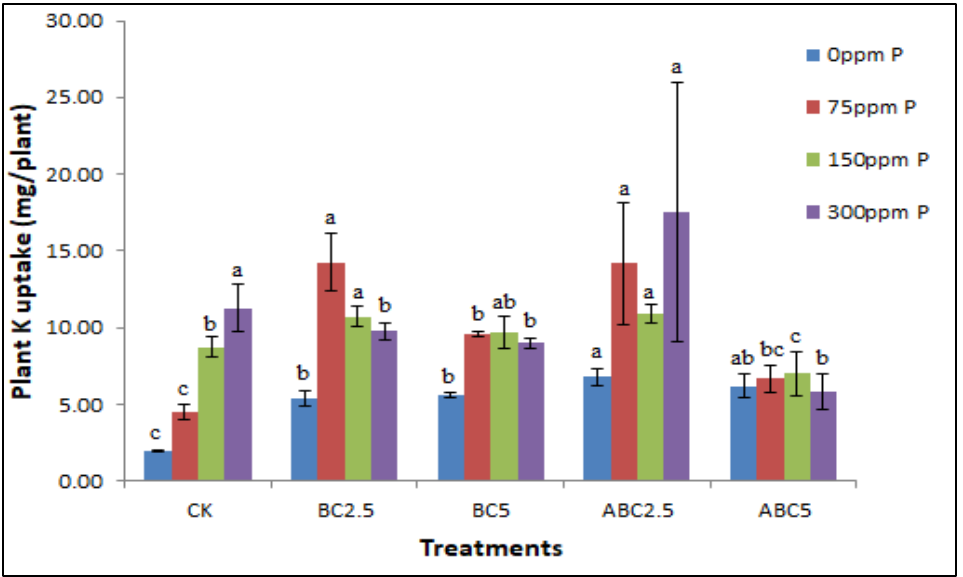
Figure 9. Effects of BC and ABC applied at different rates with different P fertilizer application rates on plant K uptake in mg/plant. Means with different letters within each fertilizer rate across each treatment indicate significant differences according to the least significant difference (LSD) test at p < 0.05. CK = Control, BC2.5 = Biochar added at 2.5% w / w , BC5 = Biochar added at 5% w / w , ABC2.5 = Acidified biochar added at 2.5% w / w , and ABC5 = Acidified biochar added at 5% w / w .